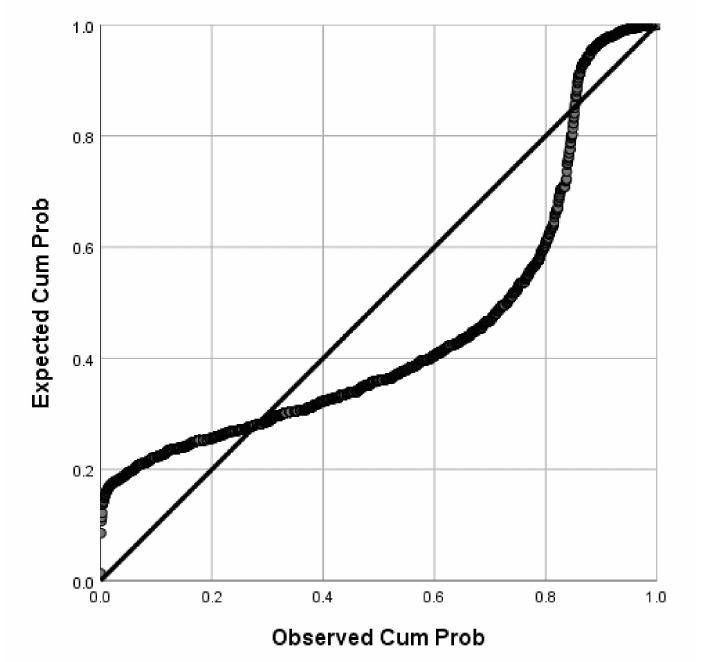
Figure 2. P-P plot of